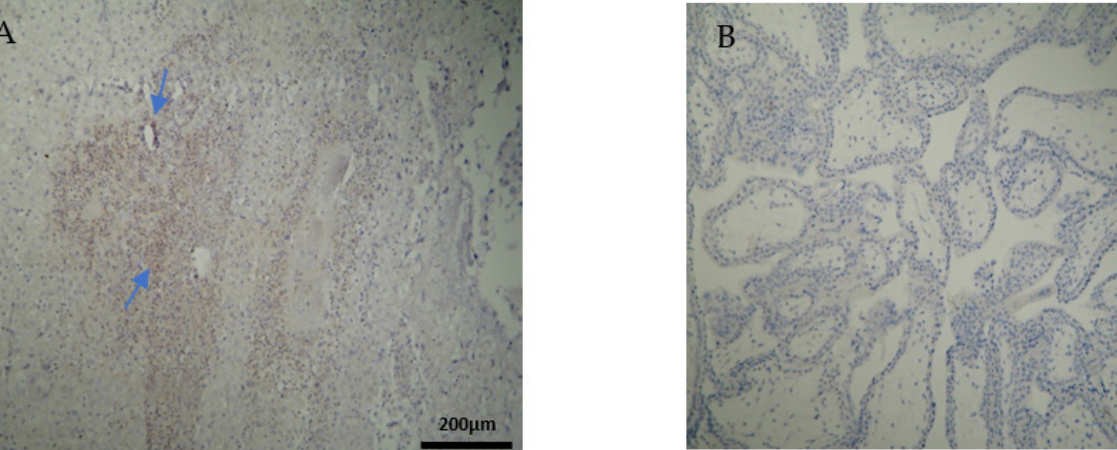
Figure 5. Evaluation of positive CD8 antigen expression. Miscarriage experimental group (EG): ( A ) Moderate expression of CD8 in the DP (4 × 10 magnification). ( B ) Negative expression of the CD8 antigen in the chorionic villi (trophoblast) (4 × 10 magnification).